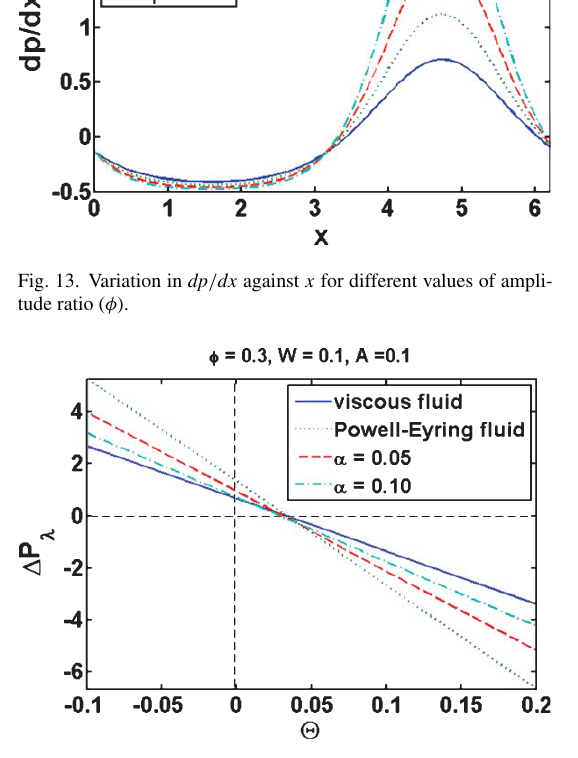
Fig. 14. Variation in (cid:12)P λ against (cid:10) for different values of slip parameter ( α